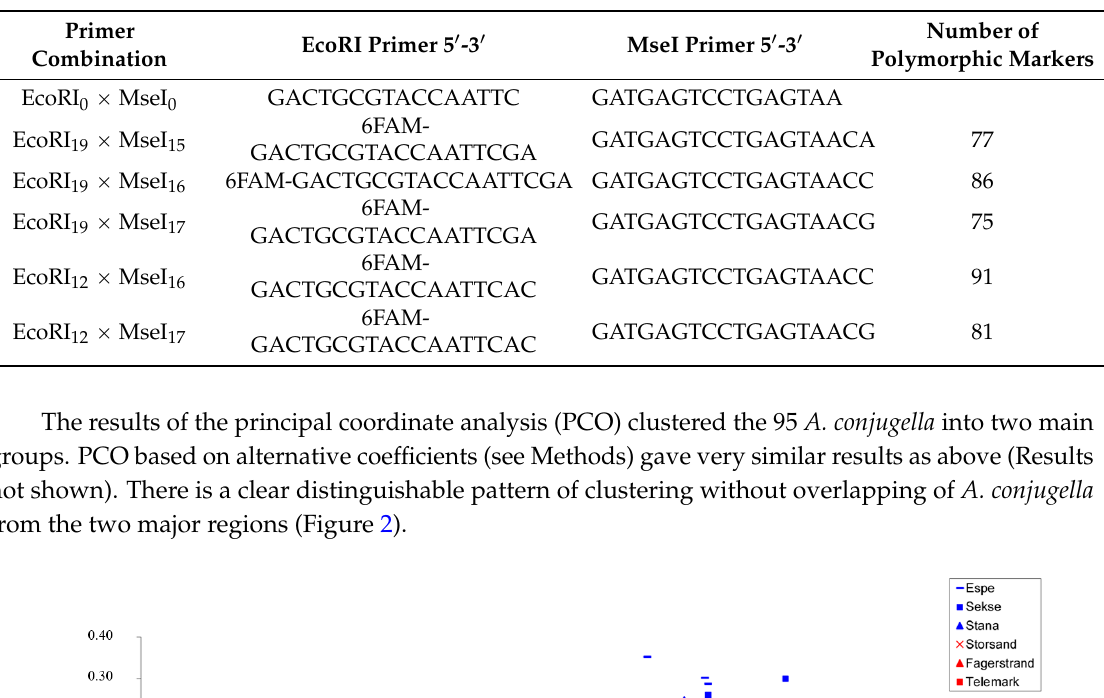
Table 2. Sequences of the Eco RI and Mse I selective primers used for AFLP analysis.